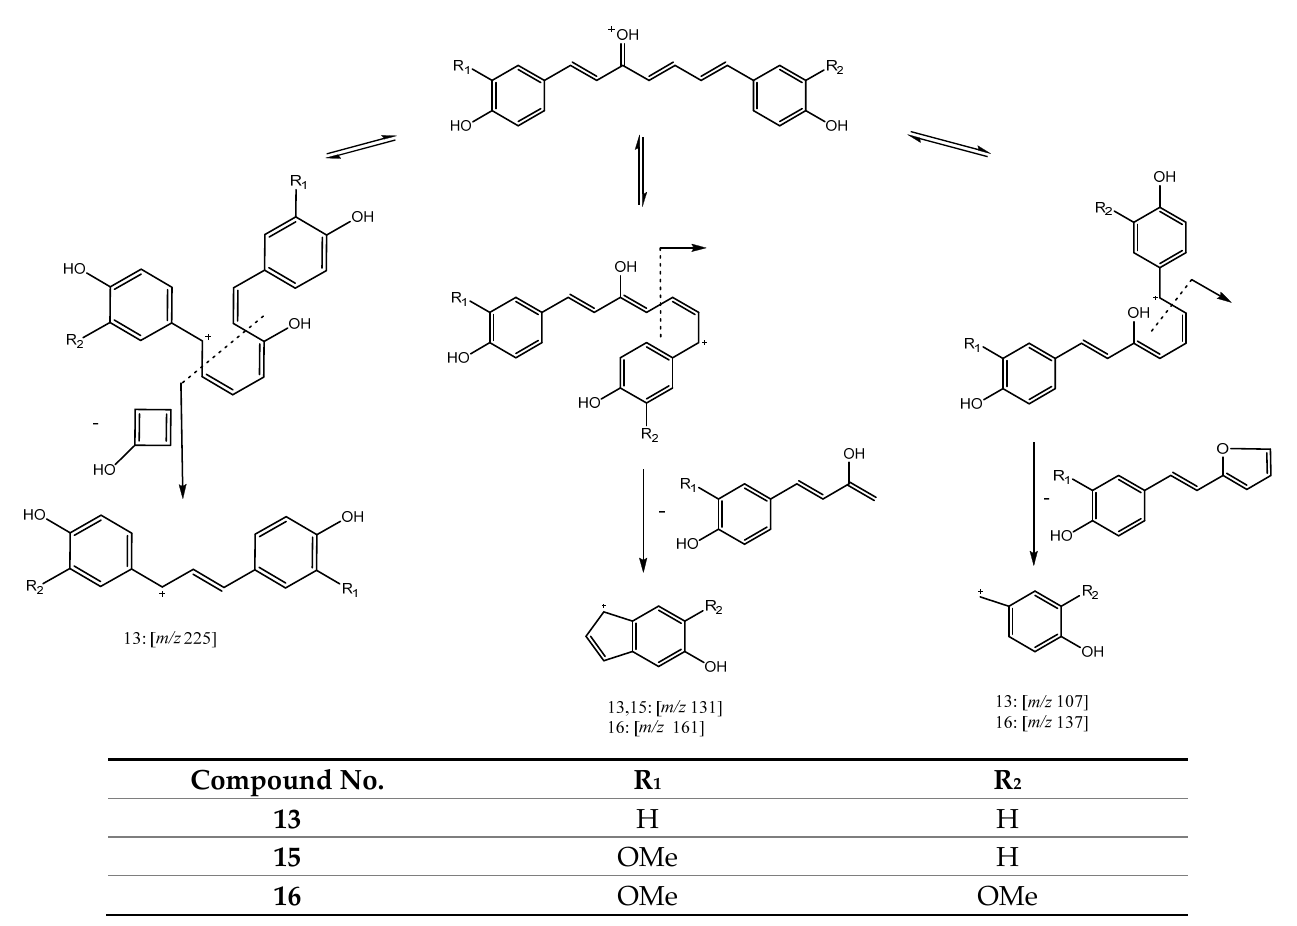
Figure 6. Fragmentation pathway for compounds 13 , 15 , 16 .